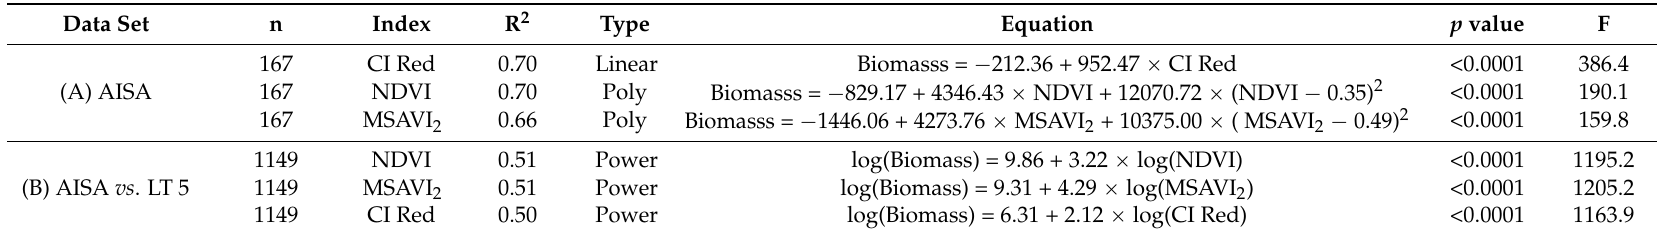
Table 2. The three best regression models for predicting S. alterniflora biomass using (A) AISA derived vegetation indices versus in situ clip plot biomass data and (B) Landsat 5 TM (LT 5) derived vegetation indices versus resampled (30 ˆ 30 m) AISA biomass map. Note that R 2 values and adjusted R 2 values (not shown)